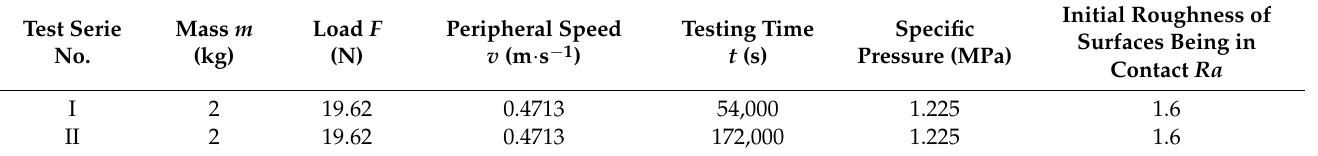
Table 1. Parameters of a tribological